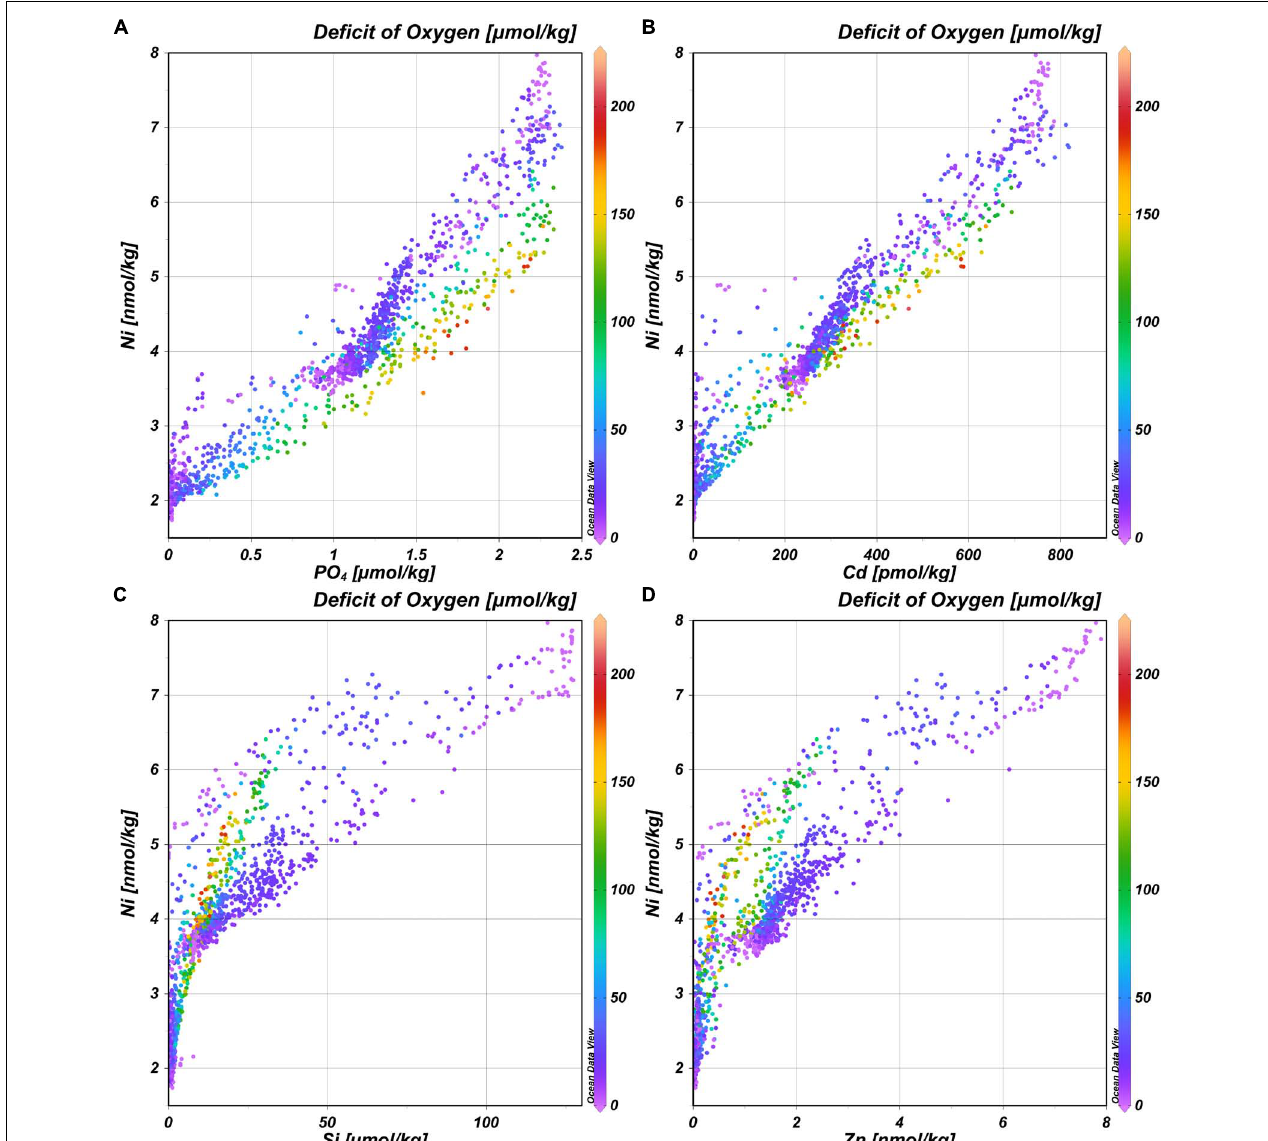
FIGURE 4 | Concentration of Ni versus the concentration of PO 4 (A) , Cd (B) , Si (C) , and Zn (D) with remineralization expressed as the deficit of oxygen ( µ mol kg - 1 ) in color scale.